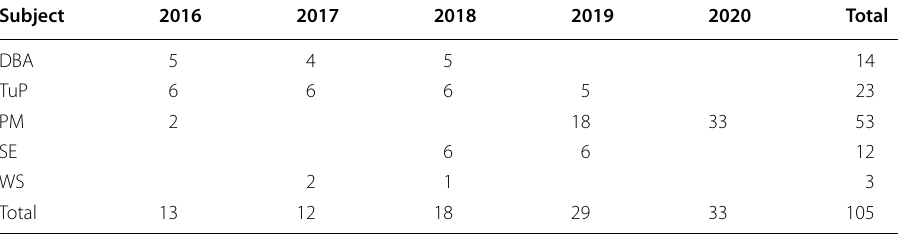
Table 1 Videos of students involved in this study, distributed by subjects and academic